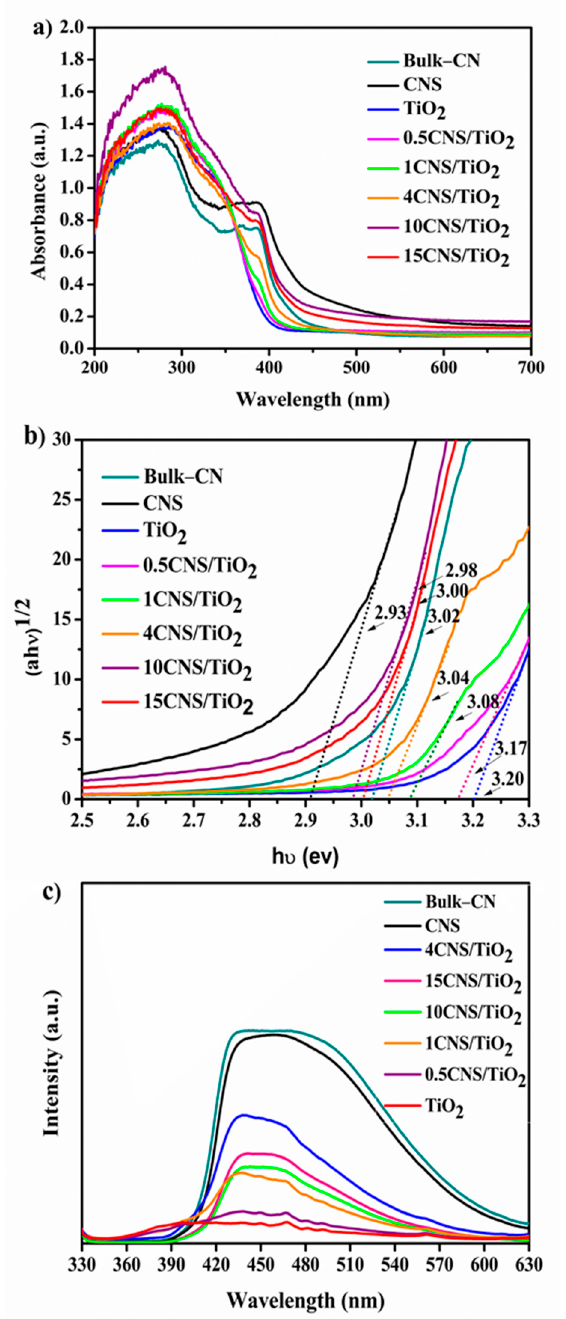
Figure 4. ( a , b ) UV-Vis DRS spectra and Tauc plot of g-C 3 N 4 , TiO 2 , and g-C 3 N 4 /TiO 2 photocatalysts, ( c ) photoluminescence spectra of the as-synthesized g-C 3 N 4 , TiO 2 , and g-C 3 N 4 /TiO 2. The band gap energy was calculated using the Tauc plot in Equation (1) and is shown in Figure 4b [55]. where α is the optical absorption coefficient, h is Planck’s constant, ν is photon frequency, A is constant, and Eg is band gap. The band gaps of pure g-C 3 N 4 , TiO 2 , and 0.5CNS/TiO 2 were calculated to be 2.93, 3.20, and 3.17 eV,